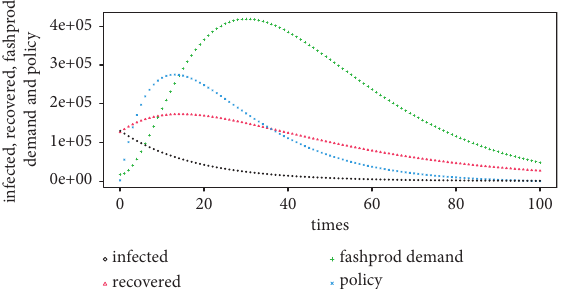
Figure 3: Time series plot of infected, recovered, demand for fashion products and